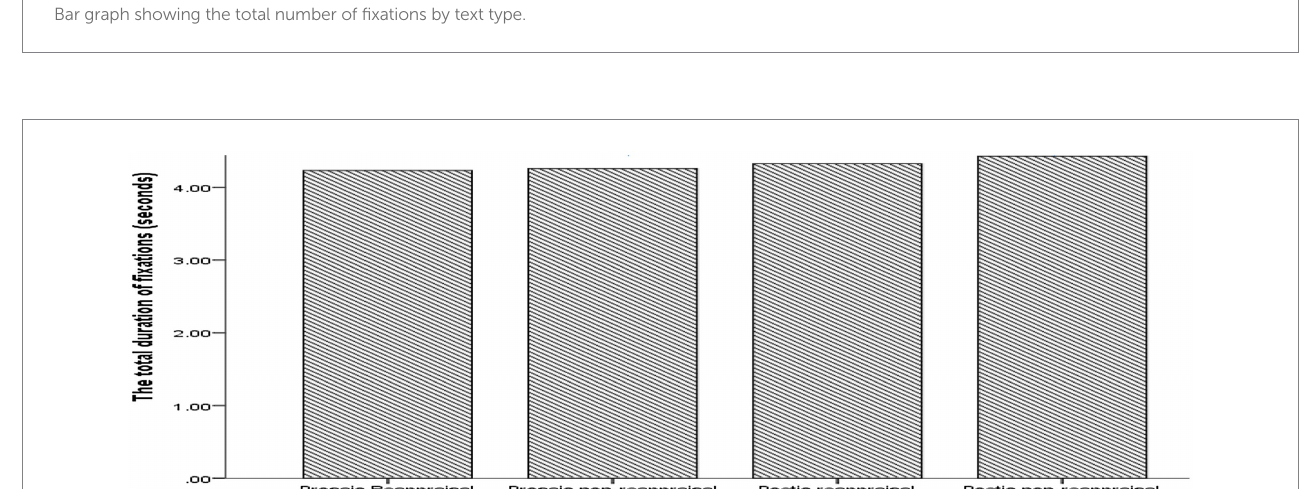
FIGURE 4 Bar graph showing the total duration of fixations by text type. Poetic reappraisal > prosaic non reappraisal; p =